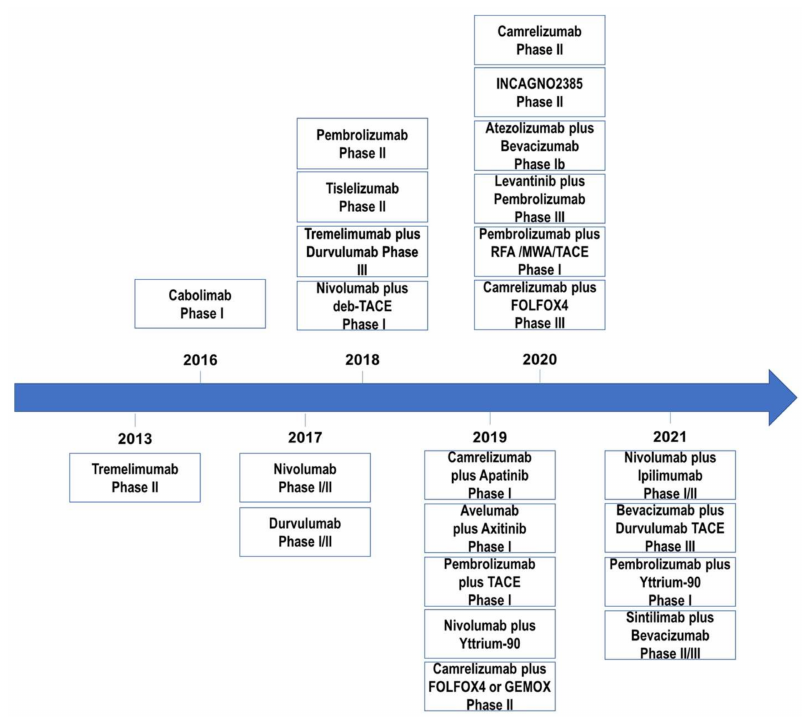
Figure 4. Development and clinical trials of immune checkpoint inhibitors as single agents or in combination with other treatments for HCC from 2013 to